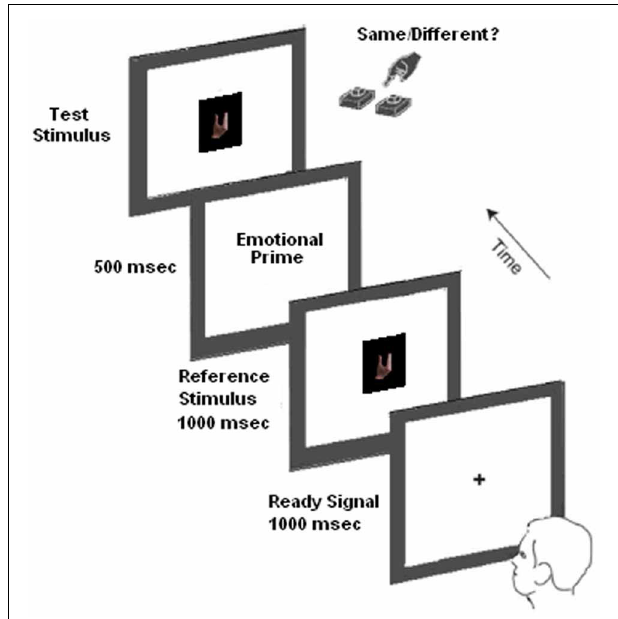
FIGURE 2 | Experimental procedure. Example of typical event trials for the detection task. In the current task, participants were required to establish, as quickly as possible, whether the test stimulus was the same as or different to the reference